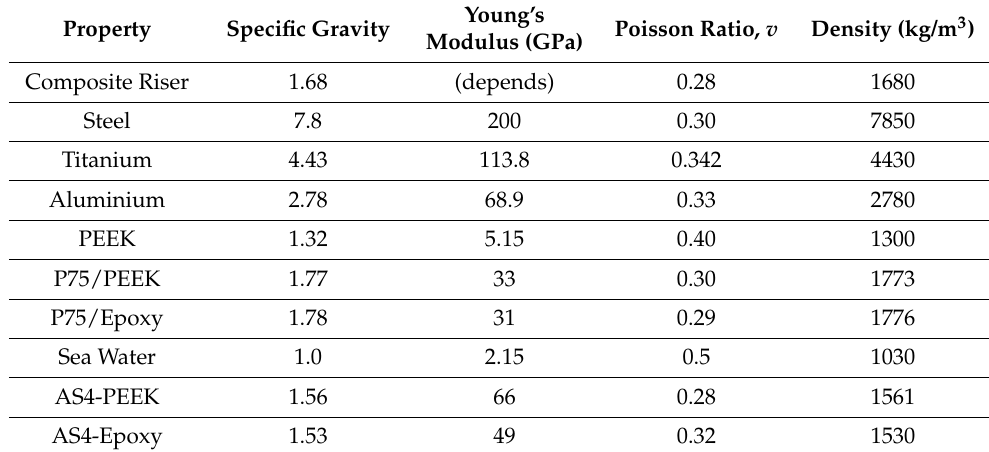
Table 4. Material attributes of composite risers compared to other materials.